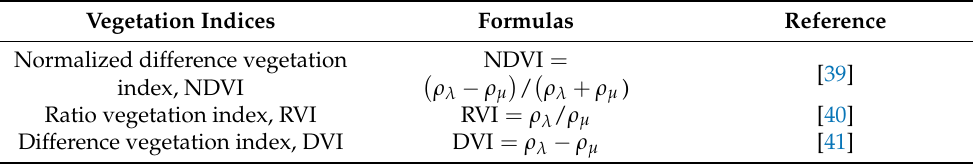
Table 1. The calculation formulae for vegetation indices.